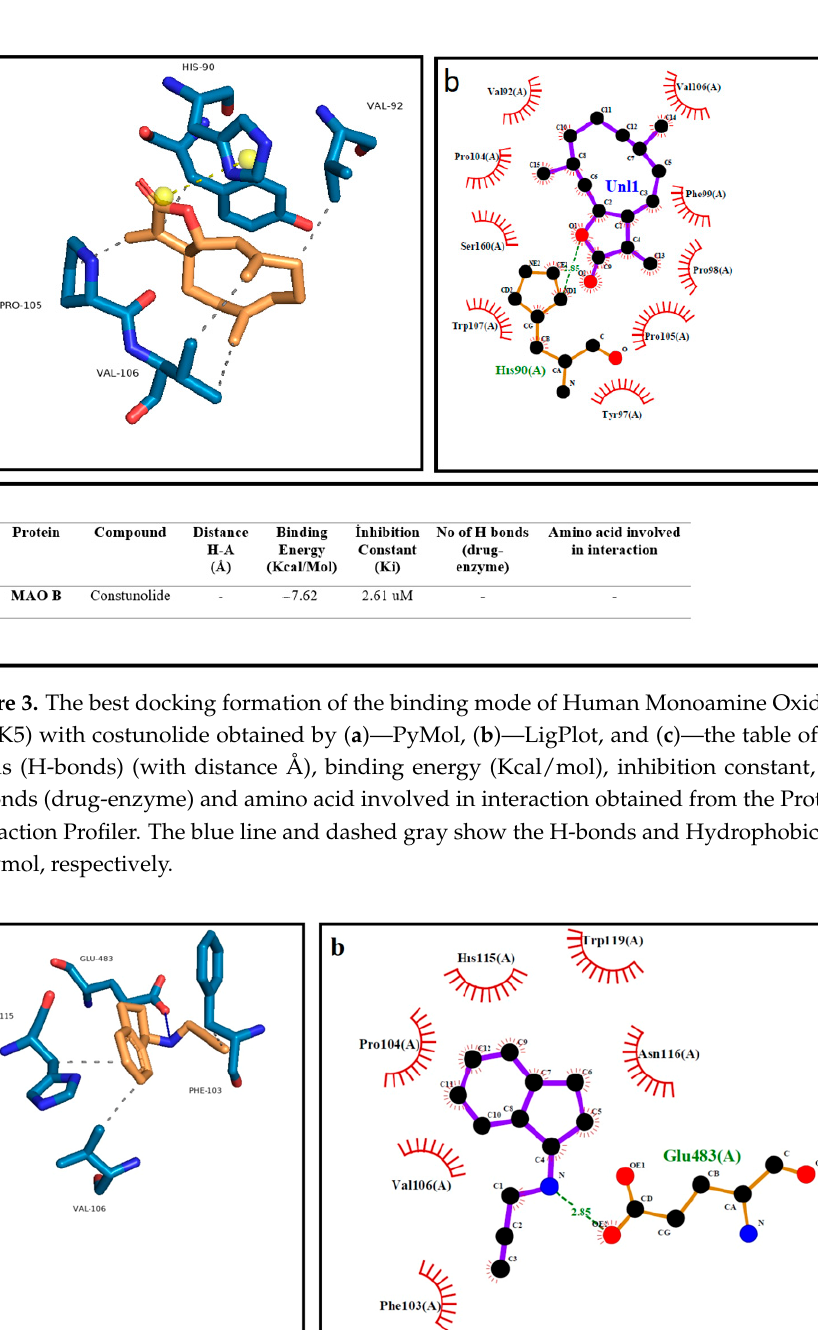
bonds (H-bonds) (with distance Å), binding energy (Kcal/mol), inhibition constant, number of H- bonds (drug-enzyme) and amino acid involved in interaction obtained from the Protein-Ligand In- teraction Pro fi ler. The blue line and dashed gray show the H-bonds and Hydrophobic Interaction in Pymol, respectively.